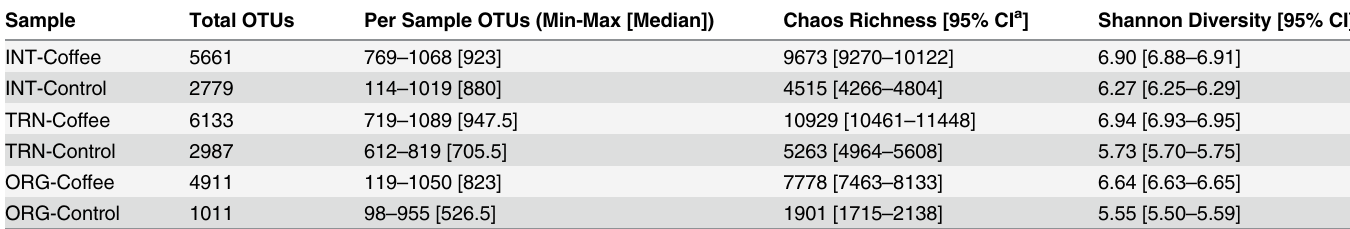
Table 3. Summary data of OTUs, richness, and